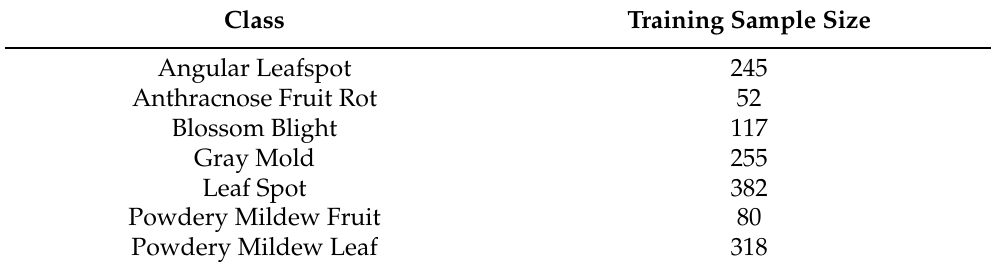
Table 5. Training Sample Size for Different